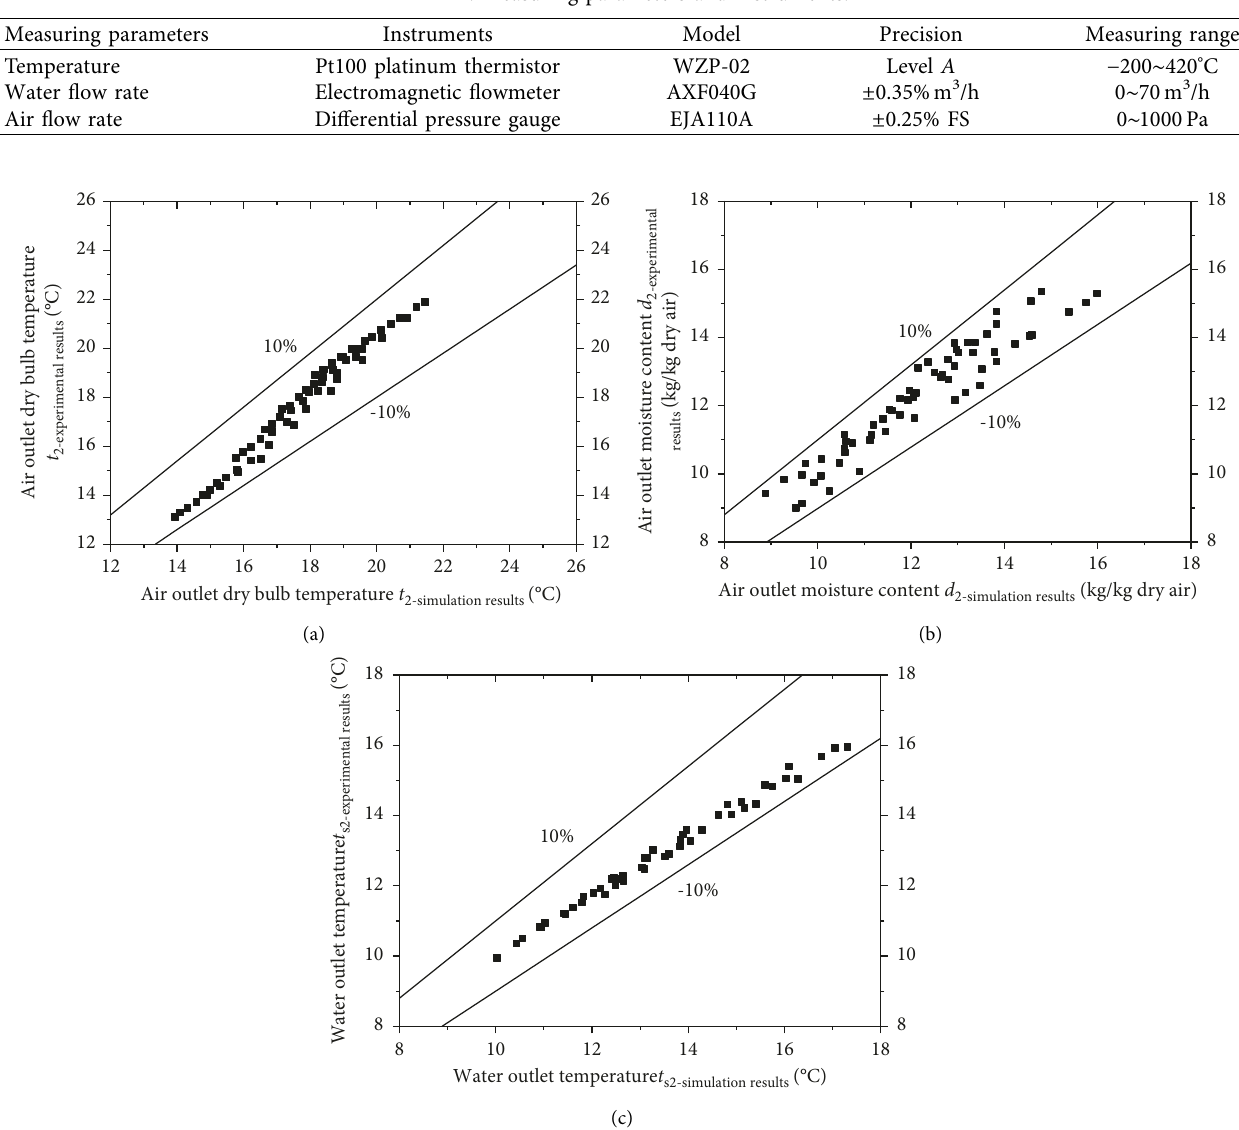
Table 2: Measuring parameters and